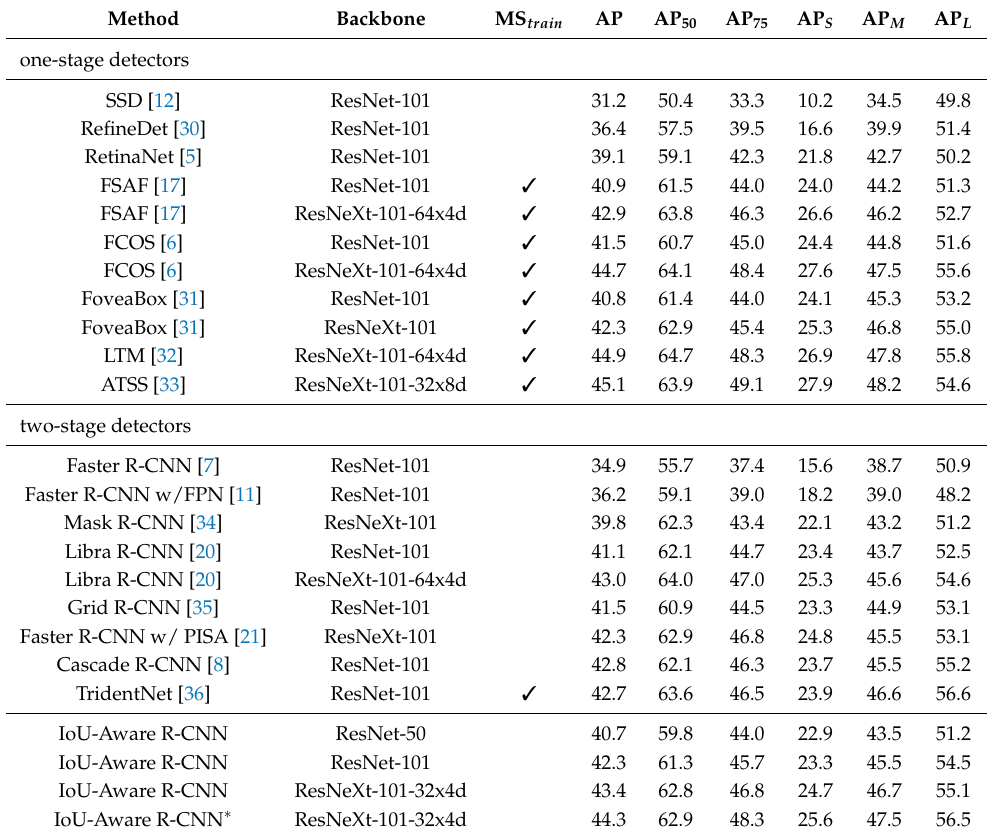
with our best performance on single-scale training is less than 0.8 point. Consider the simplicity of our auxiliary branch, it also shows the effectiveness of our method. Table 8. Comparisons with other detectors on MS COCO test-dev. “MS train ” denotes multi-scale training, otherwise using single-scale training. All experiments of our method set score_thr to 0.001, which slightly improves detection performance without a speed reduction. IoU-Aware R-CNN ∗ means that trainval dataset is used to train the detector and soft-NMS is employed at inference.